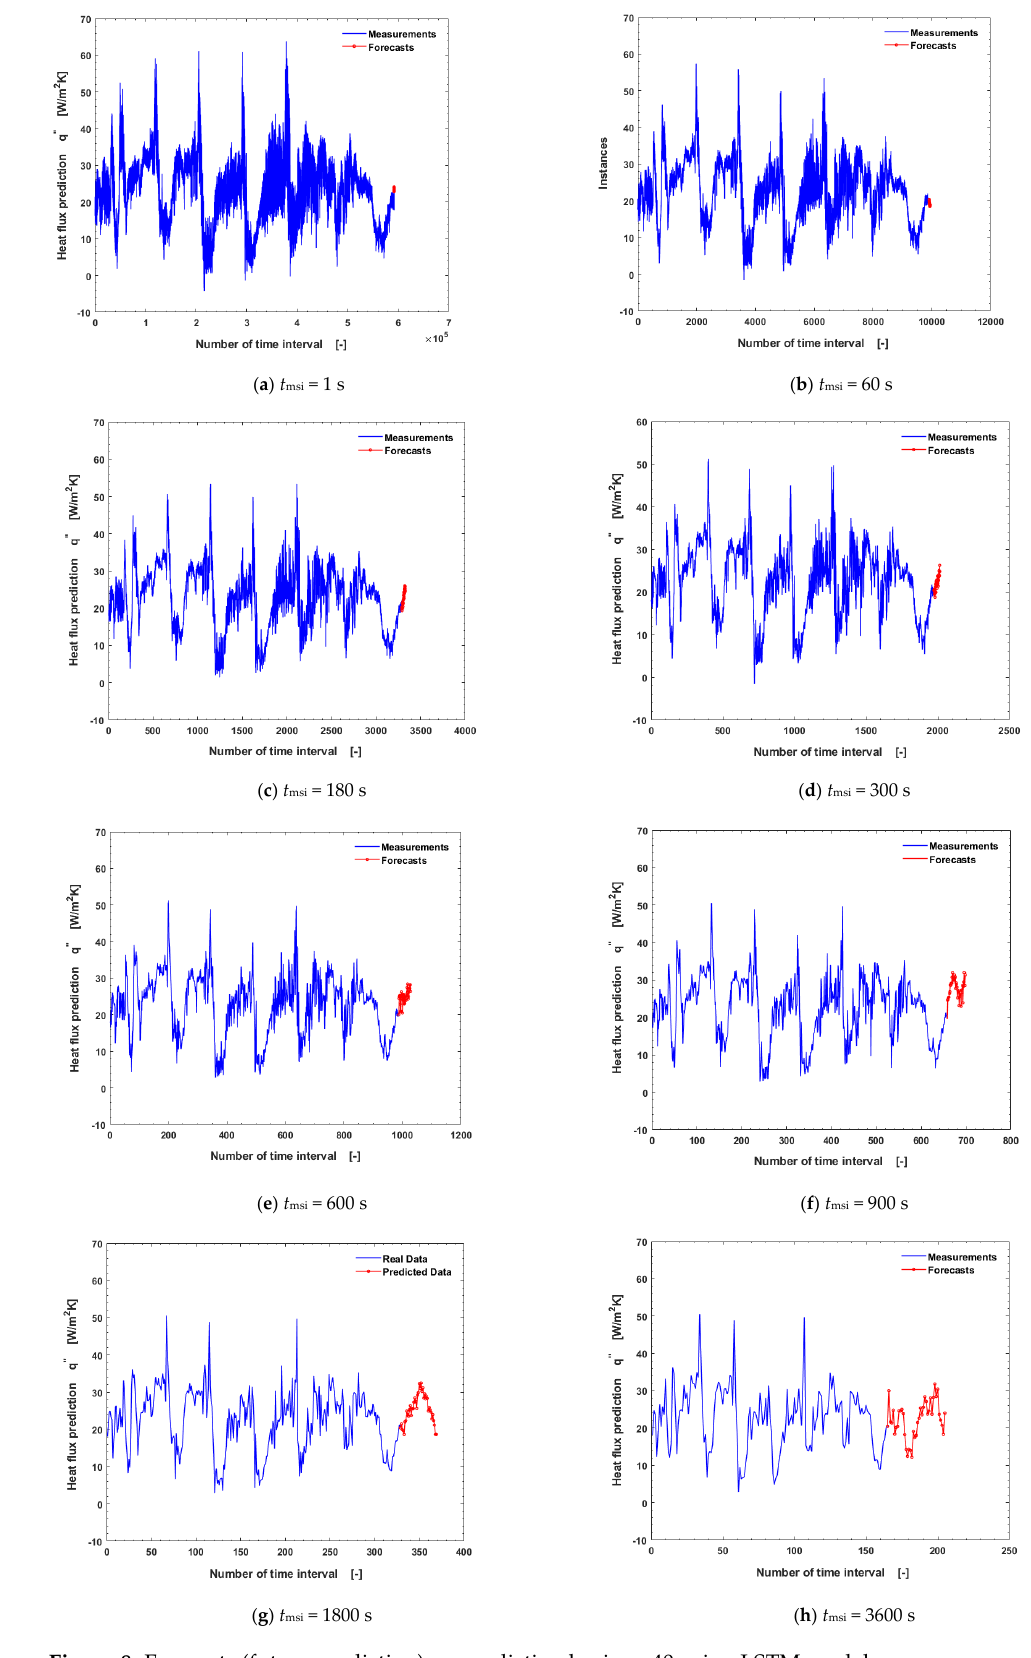
Figure 8. Forecasts (future prediction) on prediction horizon 40 using LSTM model.